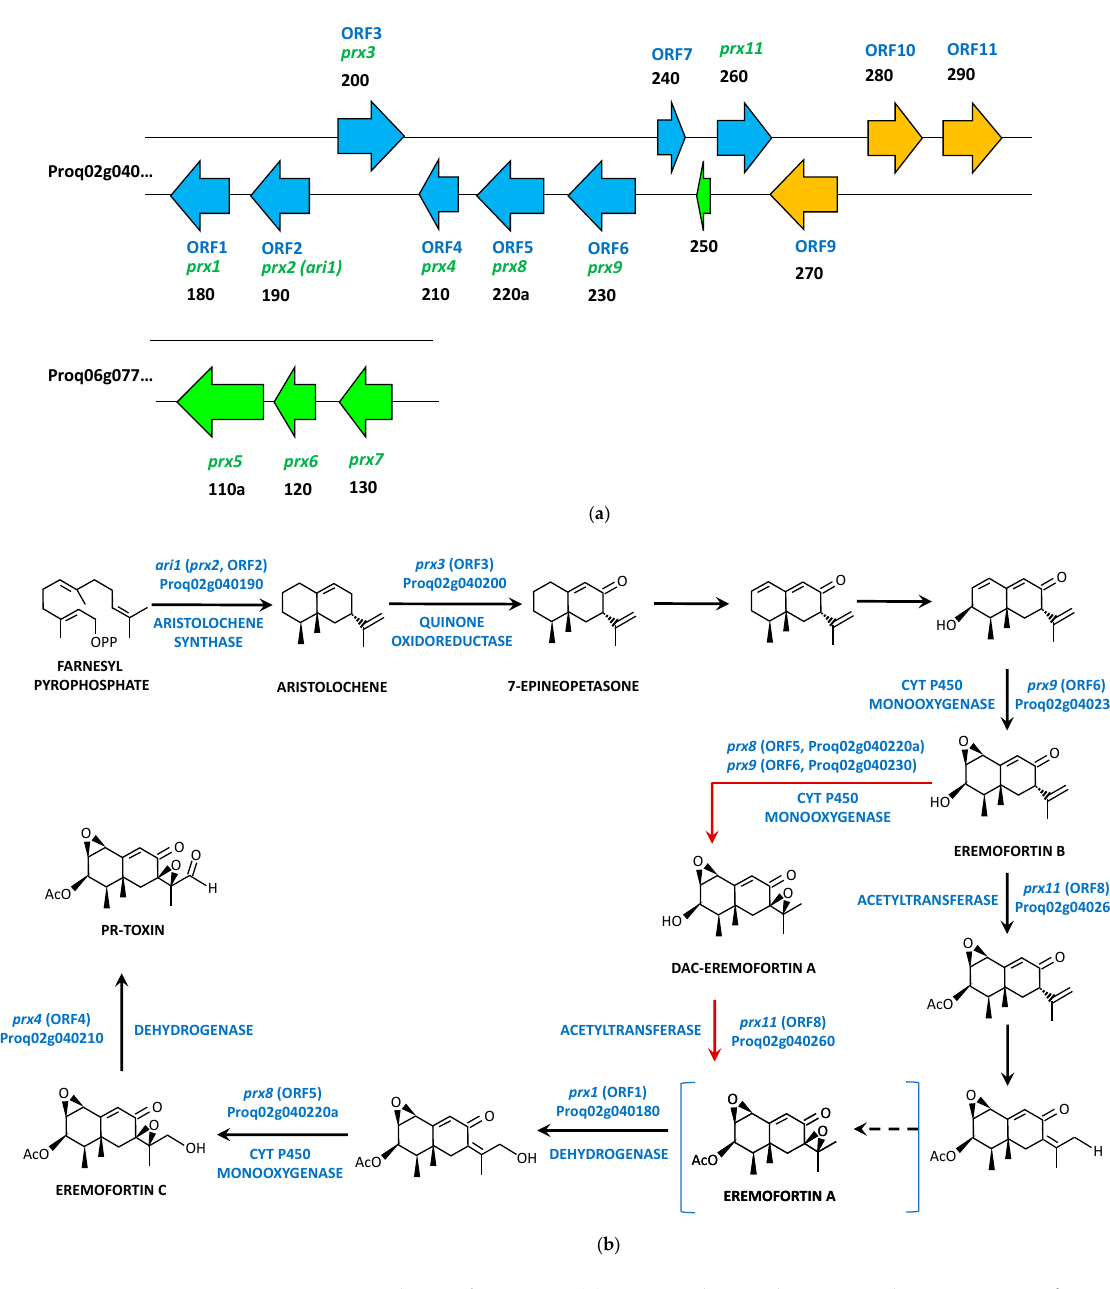
Figure 4. Biosynthesis of PR-toxin: ( a ) PR-toxin biosynthetic gene cluster in P. roqueforti . The cluster initially described by García – Estrada and Martín [34] includes genes represented as green (contig Proq06) and blue arrows contig (Proq02), whereas the cluster later described by Hidalgo et al., 2017 includes genes represented as blue and orange arrows (ORF 1 to ORF 11). The nomenclature of each gene, according to its position in each contig, is also indicated in black color; ( b ) Proposed biosynthetic pathway for PR-toxin in P. roqueforti . The alternative steps for the transformation of Eremofortin B to Eremofortin A are indicated with red arrows. Eremofortin A has been suggested to be either a shunt product or an intermediate (in blue brackets) adapted from [34,61,62].